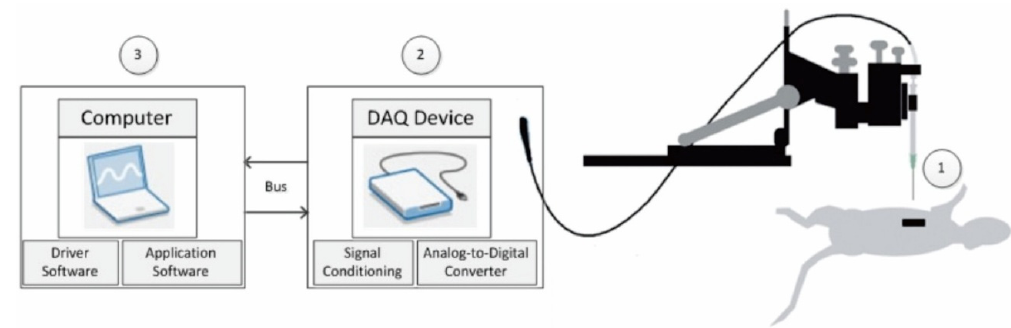
Figure 13. A potential biosensor data acquisition system for real-time in vivo corrosion monitoring: (1) needle-type microelectrode to measure corrosion behavior properties; (2) data acquisition device (DAQ) for signal conditioning and analog-to-digital converter; (3) monitoring device with installed driver software and application software. Adapted from [46].